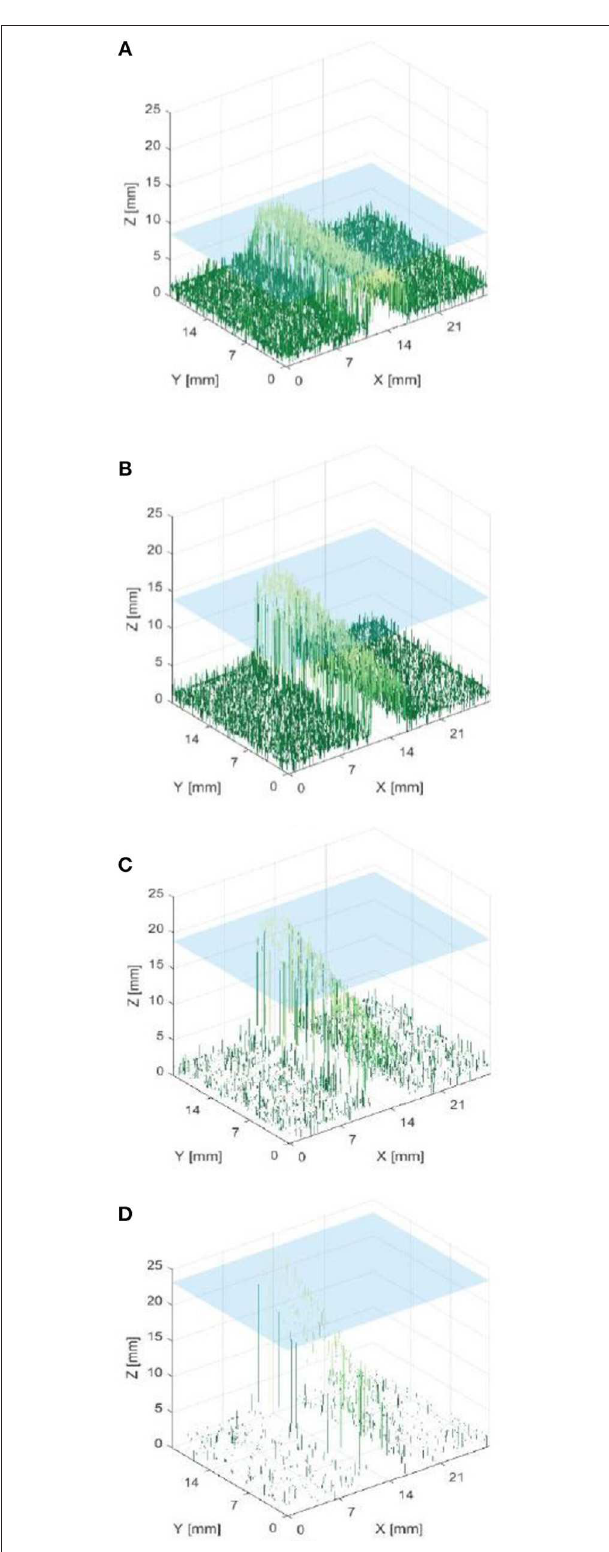
FIGURE 10 | Reconstructed depth maps for a capillary specimen positioned at various angles: 0, 15, 30, and 45 ◦ (A–D) . Phantom surface shown in